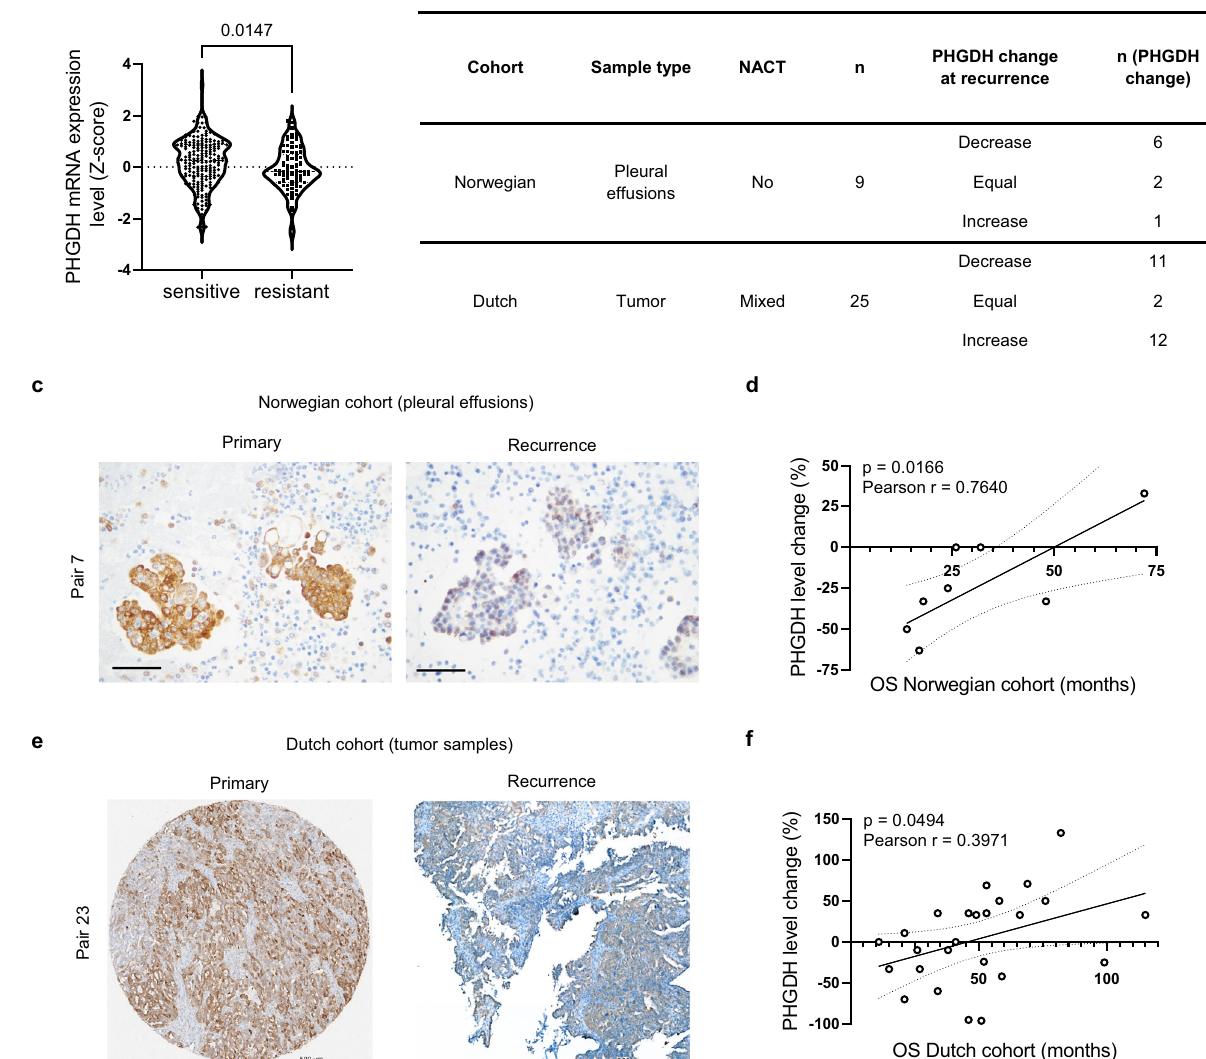
simple linear regression determined by minimizing sum of squares is shown with 95%con fi dencebands,Pearsoncorrelation r =0.7640and p =0.0166. e Exampleof PHGDH IHC staining of primary and recurrent clinical specimen of the Dutch cohort, scale bar is 500 µ m. f Correlation of PHGDH protein level change at recurrence and overall survival in the Dutch cohort, simple linear regression determined by minimizing sum of squares is shown with 95% con fi dence bands, Pearson correlation r =0.3971 and p =0.0494. Source data are provided as a Source Data fi le. NACT neoadjuvant chemotherapy, OS overall